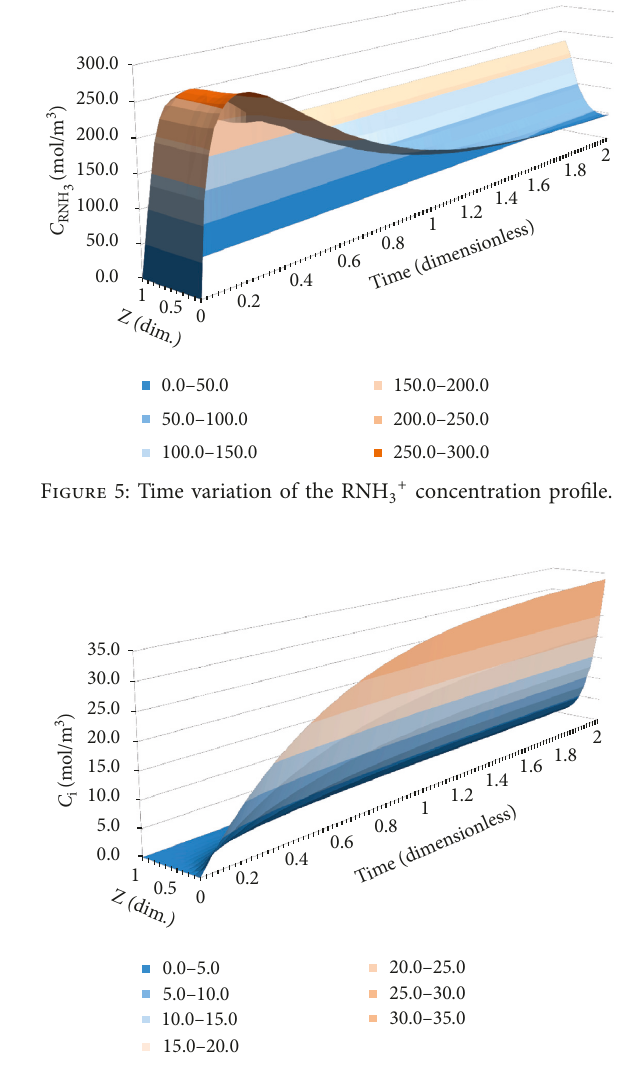
Figure 6: Time variation of the axial concentration profile of the alkanolamine